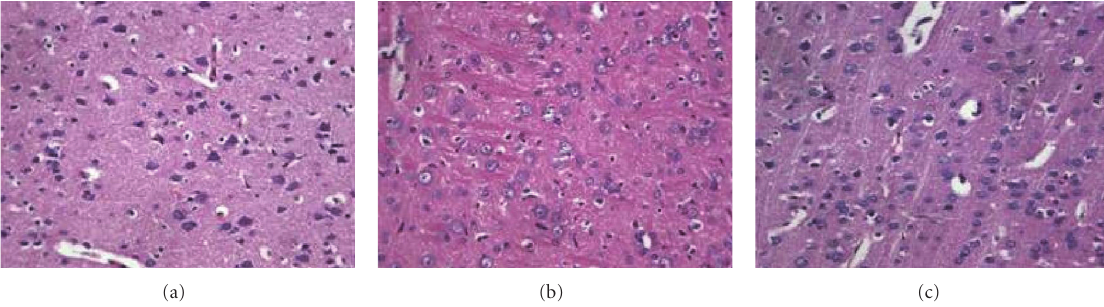
Figure 1: Pathologic changes of brain tissues ( × 400). (a) Sham group; (b) I/R group; (c) PCr